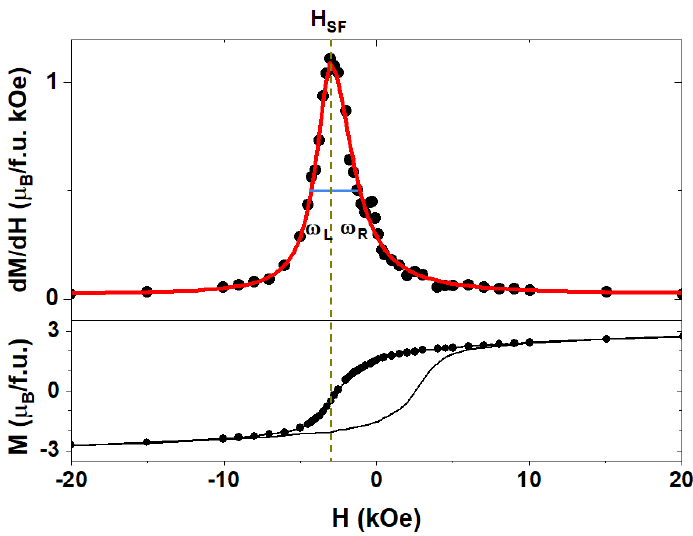
Figure 6. Switching field (top) and M ( H ) curves (bottom) for the sample annealed for 60 min with the magnetic field applied at an angle of 40 degrees. The red line is a fit with asymmetric Lorentz function.